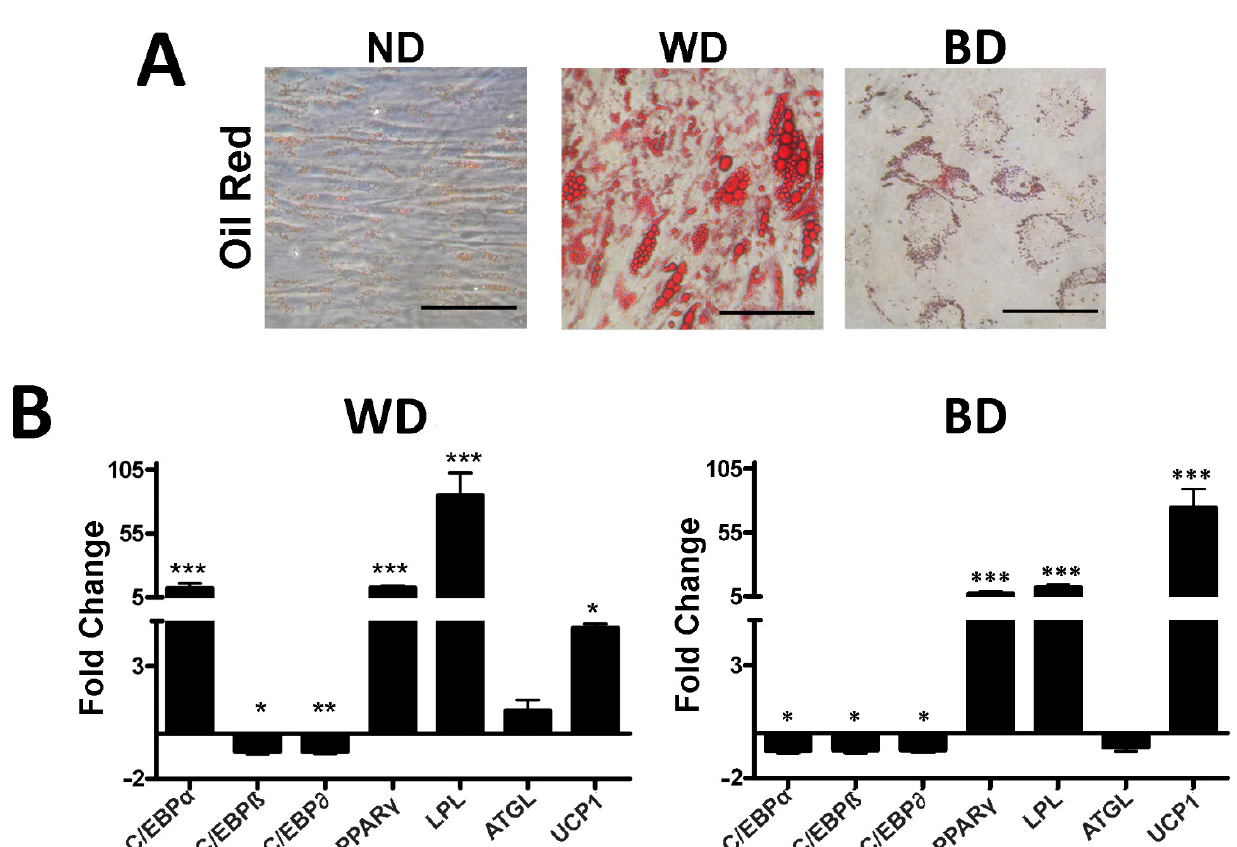
Figure 3. Lipid droplets and gene expression analysis of adipose differentiation markers. Panel A : evaluation of lipid droplets’ size by Oil Red O staining in mesenchymal stromal cells (MSCs). Scale bar: 100 µ m. Panel B : histogram shows RT-qPCR analysis, mRNA expression levels of C/EBP α , C/EBP β , C/EBP δ , PPAR γ , LPL , ATGL , and UCP1 MSCs in white differentiation and brown differentiation. GAPDH mRNA was used as an internal control. Data are expressed as fold change using the delta–delta CT method ( ± SD, n = 5 biological replicates; * p < 0.05, ** p < 0.01, *** p < 0.001). ND: no differentiation cues; WD: white differentiation; BD: brown differentiation.